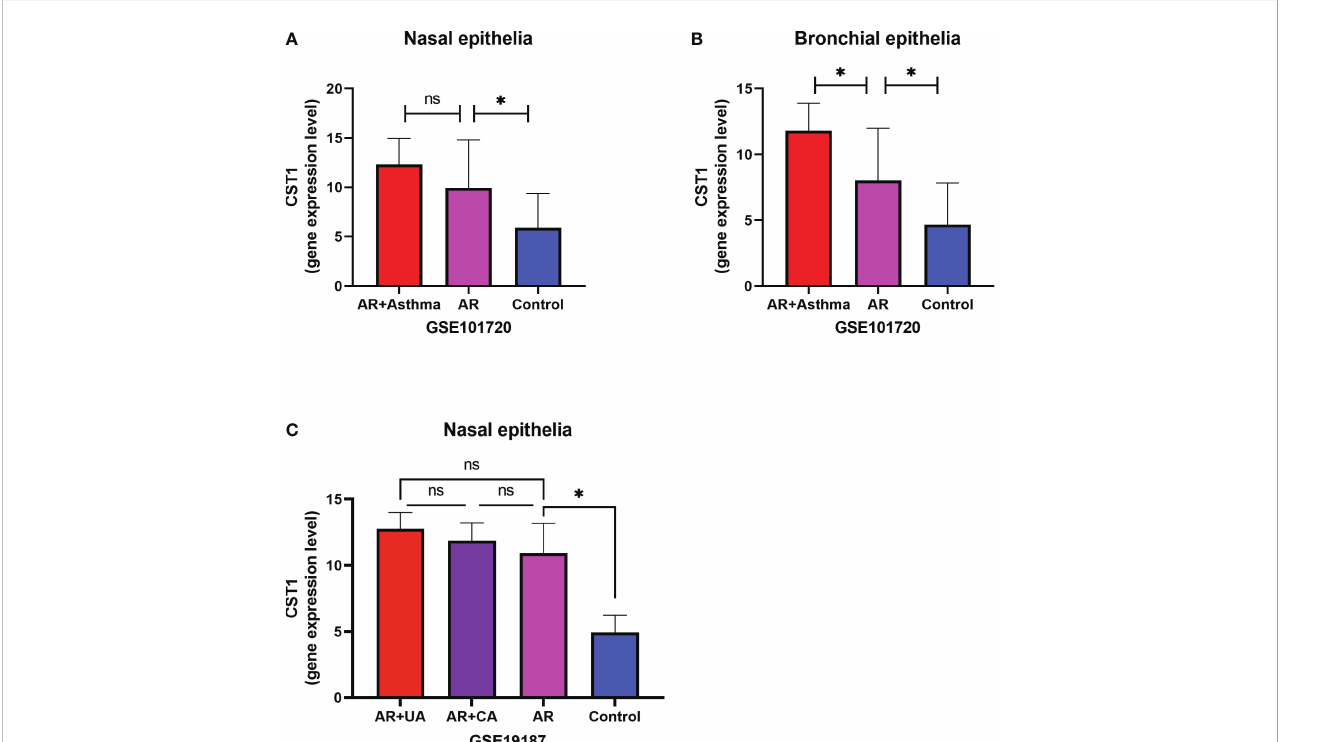
FIGURE 5 Expression levels of CST1 in different comorbidities. (A) Histograms show the expression levels of CST1 in nasal epithelium in AR comorbid asthma, AR alone, and controls in GSE101720. (B) Histograms show the expression levels of CST1 in bronchial epithelium in AR comorbid asthma, AR alone and controls in GSE101720. (C) The histogram shows the expression levels of CST1 in nasal epithelium in AR comorbid UA, AR comorbid CA, AR alone and control group in GSE19187. AR, Allergic Rhinitis; UA, Uncontrolled Asthma; CA, Controlled Asthma; * P<0.05. ns, no signi fi cance.